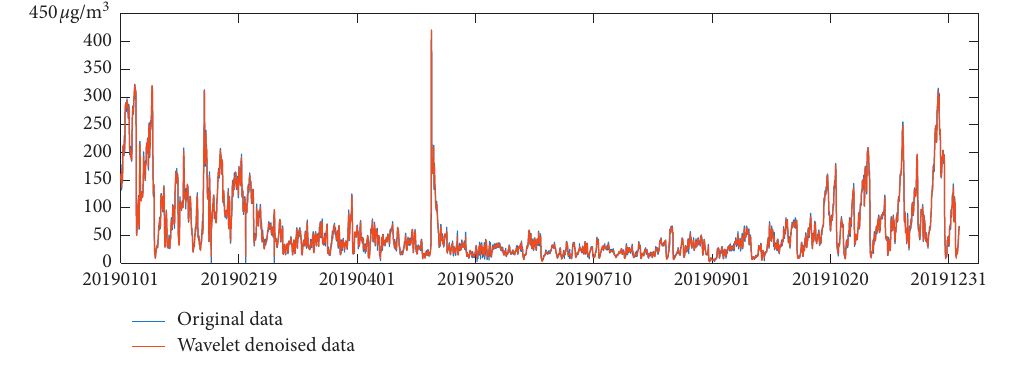
Figure 6: Contrast diagram before and after wavelet denoising. Table 3: The forecasting results after wavelet